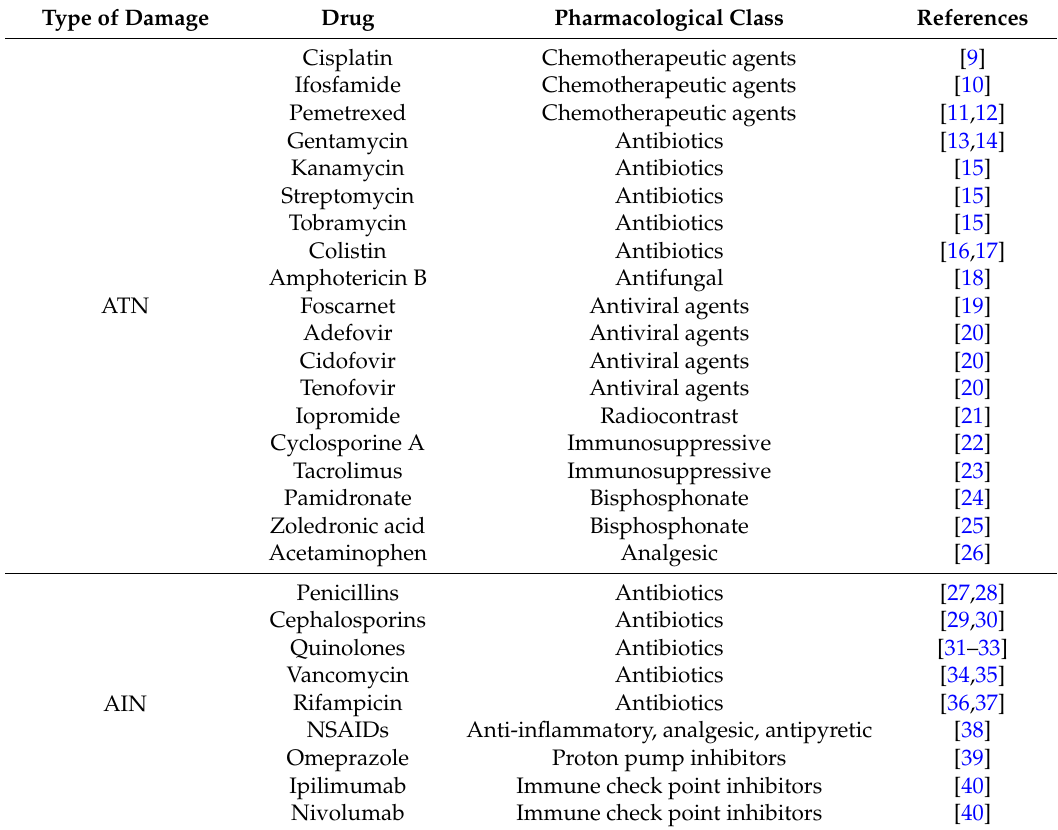
Table 1. Drugs responsible for acute kidney